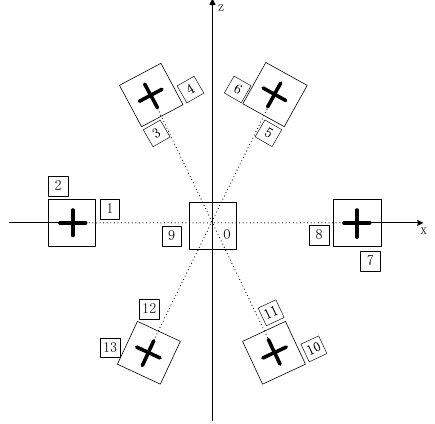
Figure 1. Circular array antenna